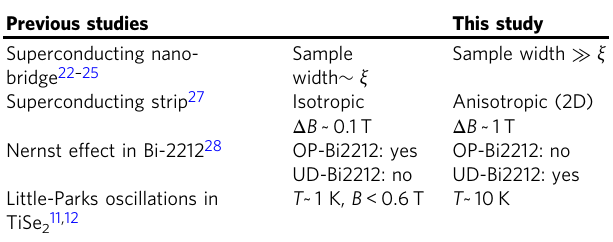
Table 1 Comparison between the resistance oscillations of this work and the previously reported low- fi eld oscillations in